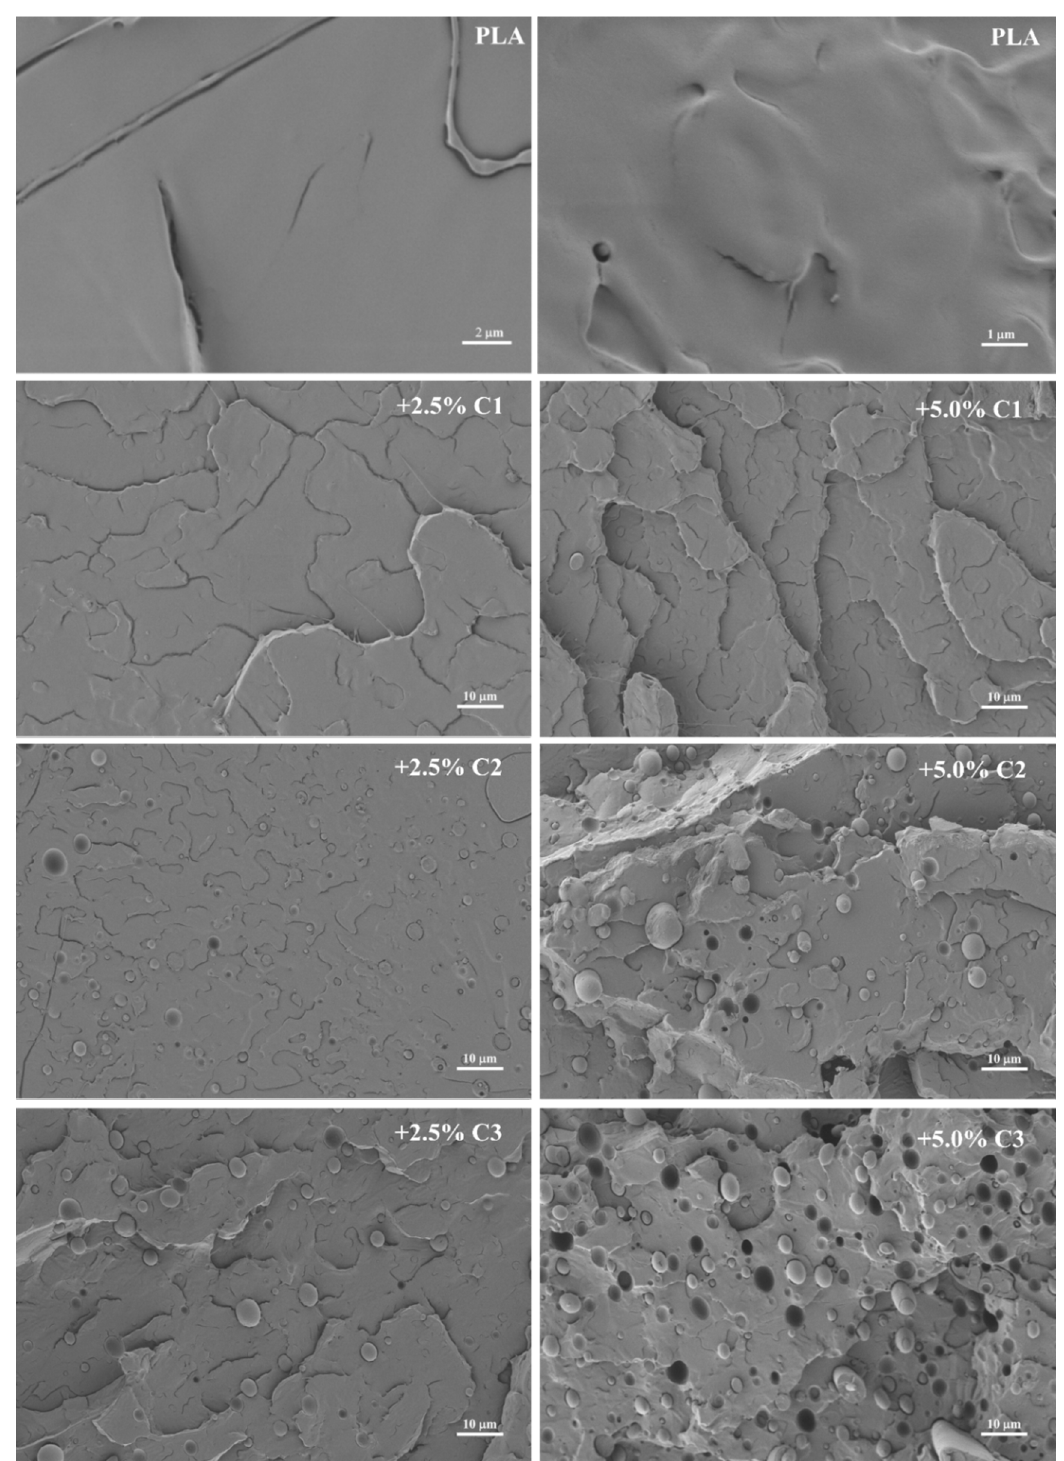
Figure 2. SEM micrographs of PLA (two magnifications, 5000 × and 10,000 × ) and PLA + Compatibilizers (2.5 and 5.0%) magnified 1000 × g .